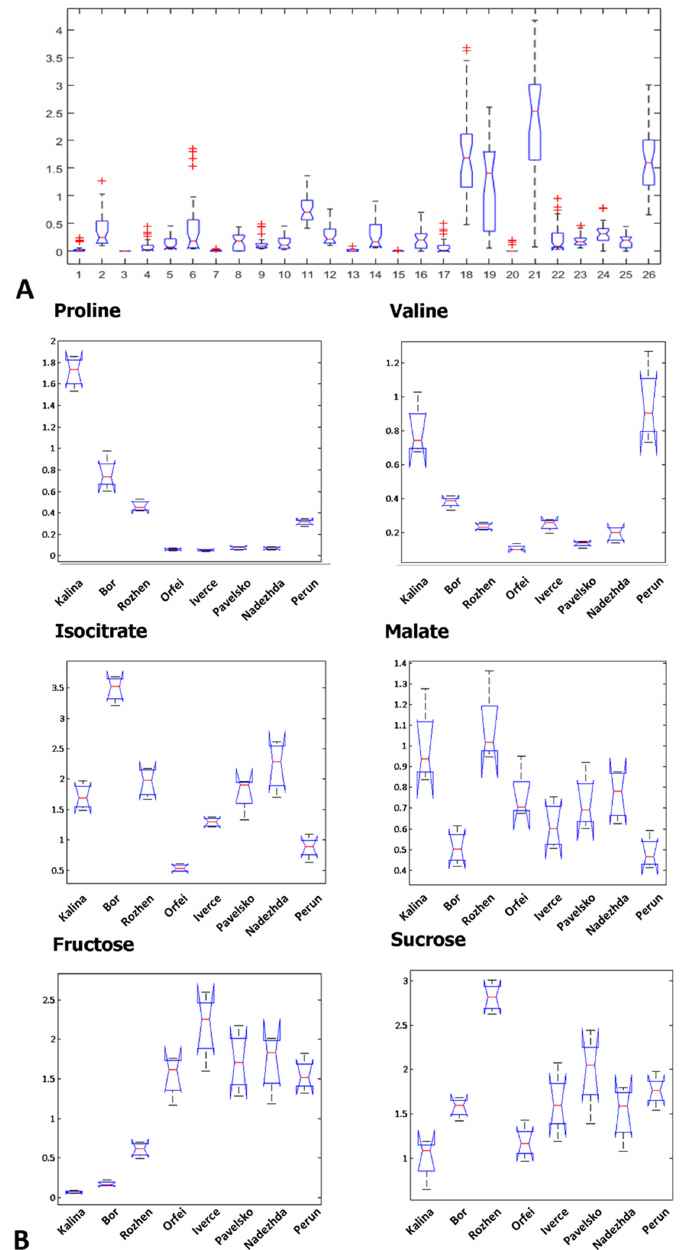
1 Figure 3. Variance in quantity of identified metabolites in different potato cultivars. Box plots represents the first and third quartile in blue, median mean with red and maximum and minimum means with bars. Outlayers are given with “+” in red ( A ) Box plot charts of means of each metabo- lite, measured in all potato cultivars. The number of metabolites in x axis are given as follows: (1) alanine; (2) valine; (3) urea; (4) leucine; (5) isoleucine; (6) proline; (7) glycine; (8) fumaric acid; (9) serine; (10) threonine; (11) malic acid; (12) asparatic acid; (13) methionine; (14) pyroglutamic acid; (15) 2-aminobutyric acid; (16) glutamic acid; (17) phenylalanine; (18) iso-citric acid; (19) fructose; (20) tyrosine; (21) glucose; (22) myo-inositol; (23) C16:0 (palmitic acid); (24) C18:0 (stearic acid); (25) ethanolamine phosphate;; (26) sucrose ( B ) Box plots of means of the metabolites with the higher variation between the potato cultivars. Each measurement is performed with four